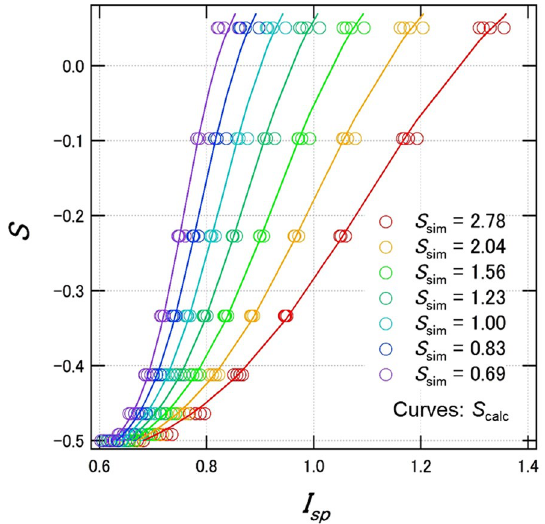
Figure 3. S − I sp characteristics at d = 20 nm and n sub = 1.524. Dots indicate S sim , i.e., a representation of the S sim − I sp − ξ 2 plots (Fig. 2b) viewed from the S − I sp plane. The sigmoidal curves show fitting results of S calc (eg. 1).